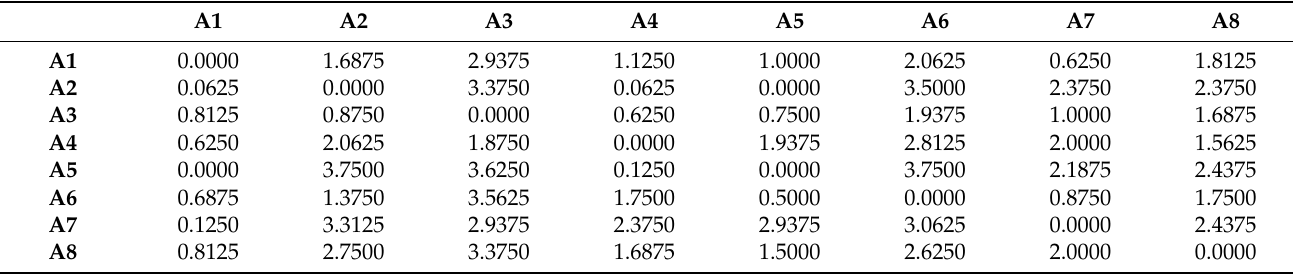
Table 3. Average direct influence matrix X*